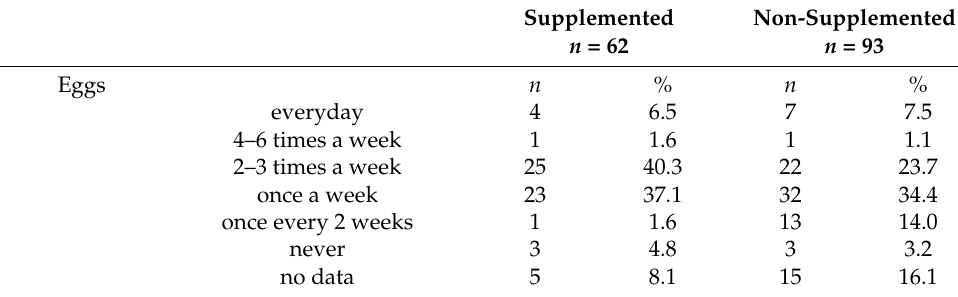
Table A5. Eggs consumption among investigated patients.